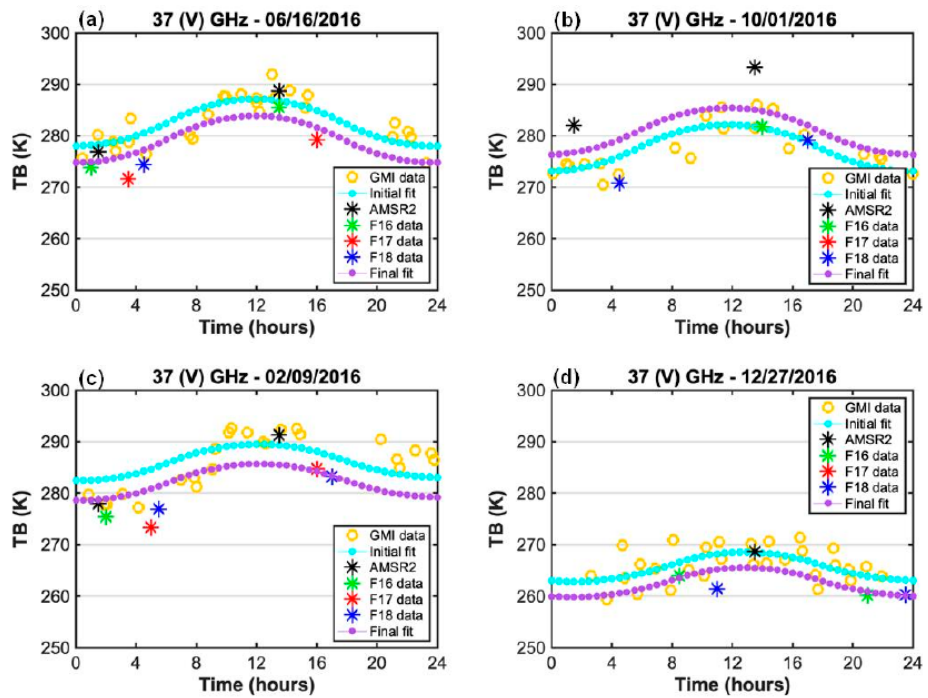
Figure 4. Diurnal variations of interpolated TB at 37 GHz vertical polarization for ( a ) 17.9 ◦ S and 36.4 ◦ E with wooded and non-wooded grassland land cover for June 16, 2016; ( b ) 8.1 ◦ S and 26.6 ◦ E with deciduous woodland land cover for 1 October 2016; ( c ) 17.4 ◦ N and 28.1 ◦ E with non-vegetated desert land cover for 9 February 2016; and ( d ) 27.4 ◦ N and 115.1 ◦ E with evergreen broad-leaved and needle-leaved forest land cover for 27 December 2016. Time in each subplot is in local solar hours. 3.2. Computation of Diurnal Cycle of Land TBs above Latitude 68 ◦ N and below Latitude 68 ◦